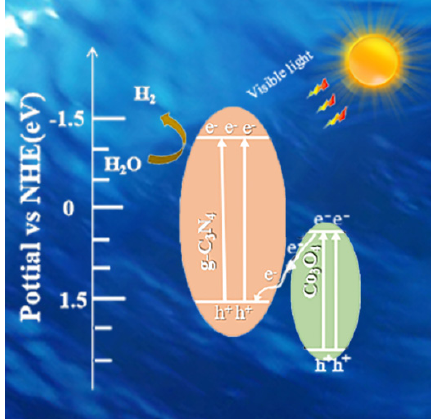
Figure 11. Proposed mechanism of photocatalytic system.